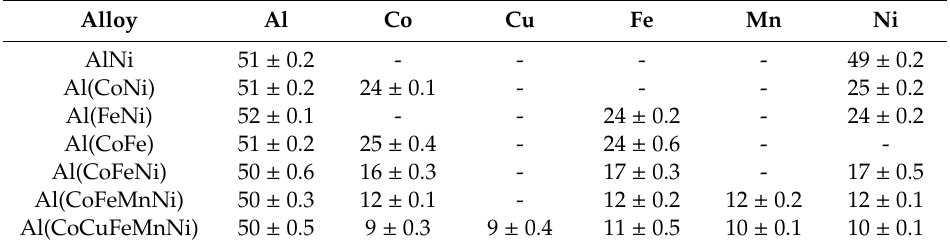
Figure 6. SEM-BSE image and elemental mapping of homogenized AlNi binary aluminide, homogenized at 1373 K for 144 h. Table 2. Elemental compositions (at.%) in the homogenized multicomponent B2